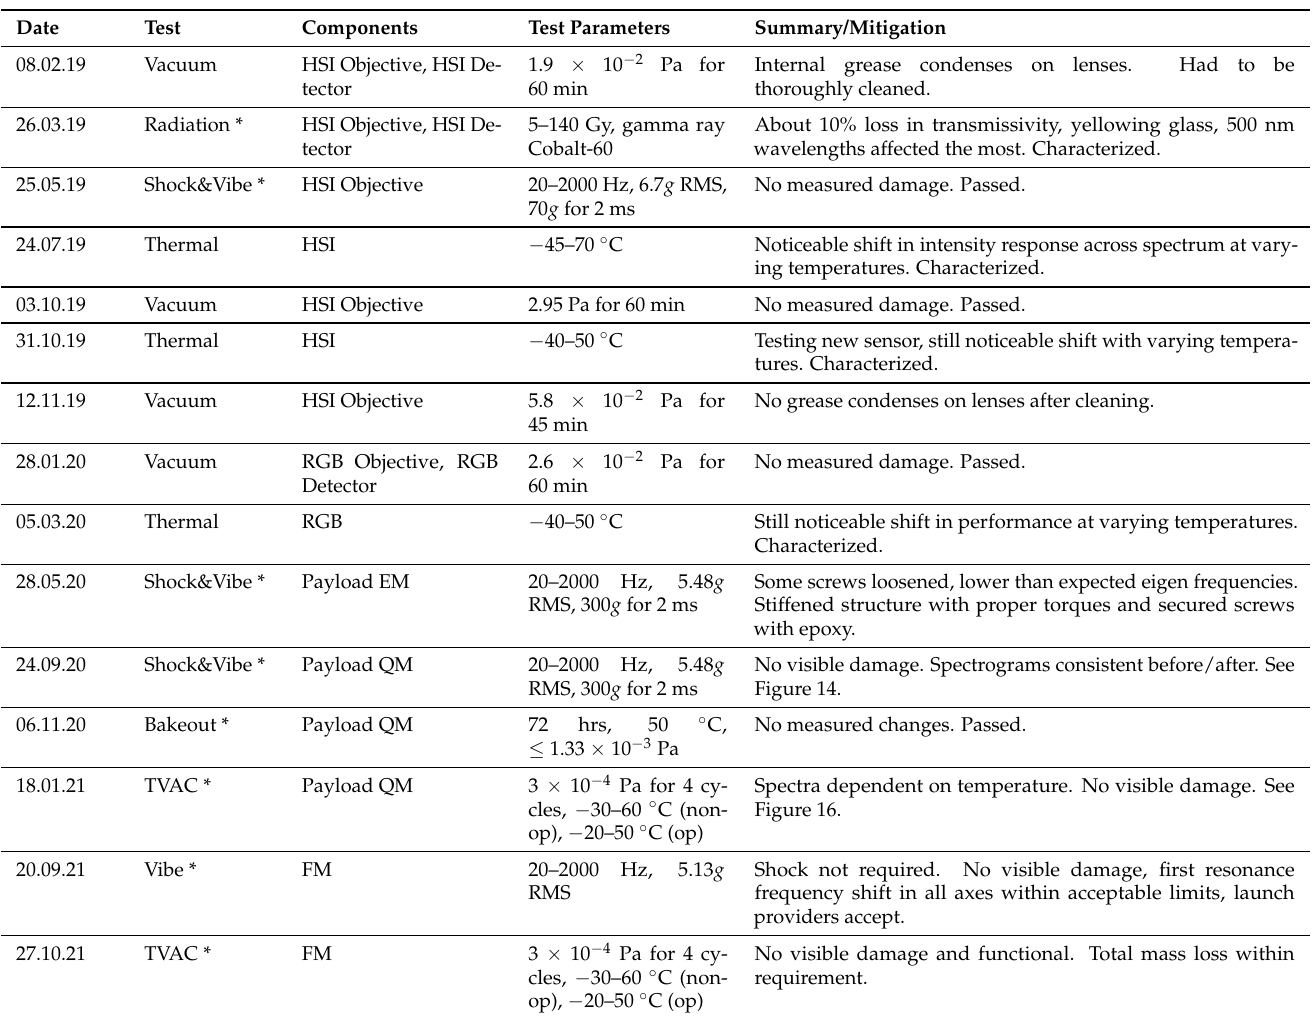
Table 4. Summary of environmental testing: from the preliminary BBMs to the fully integrated